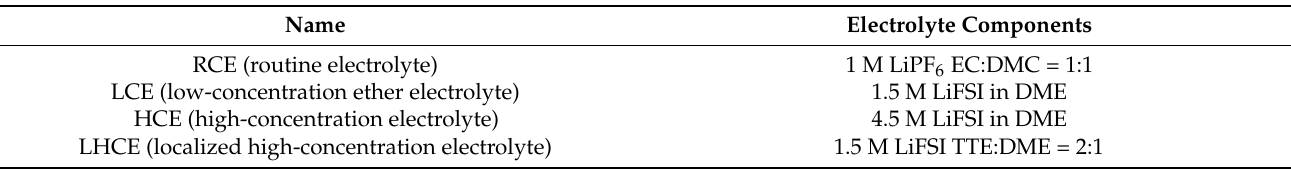
Table 1. The prepared electrolytes used in